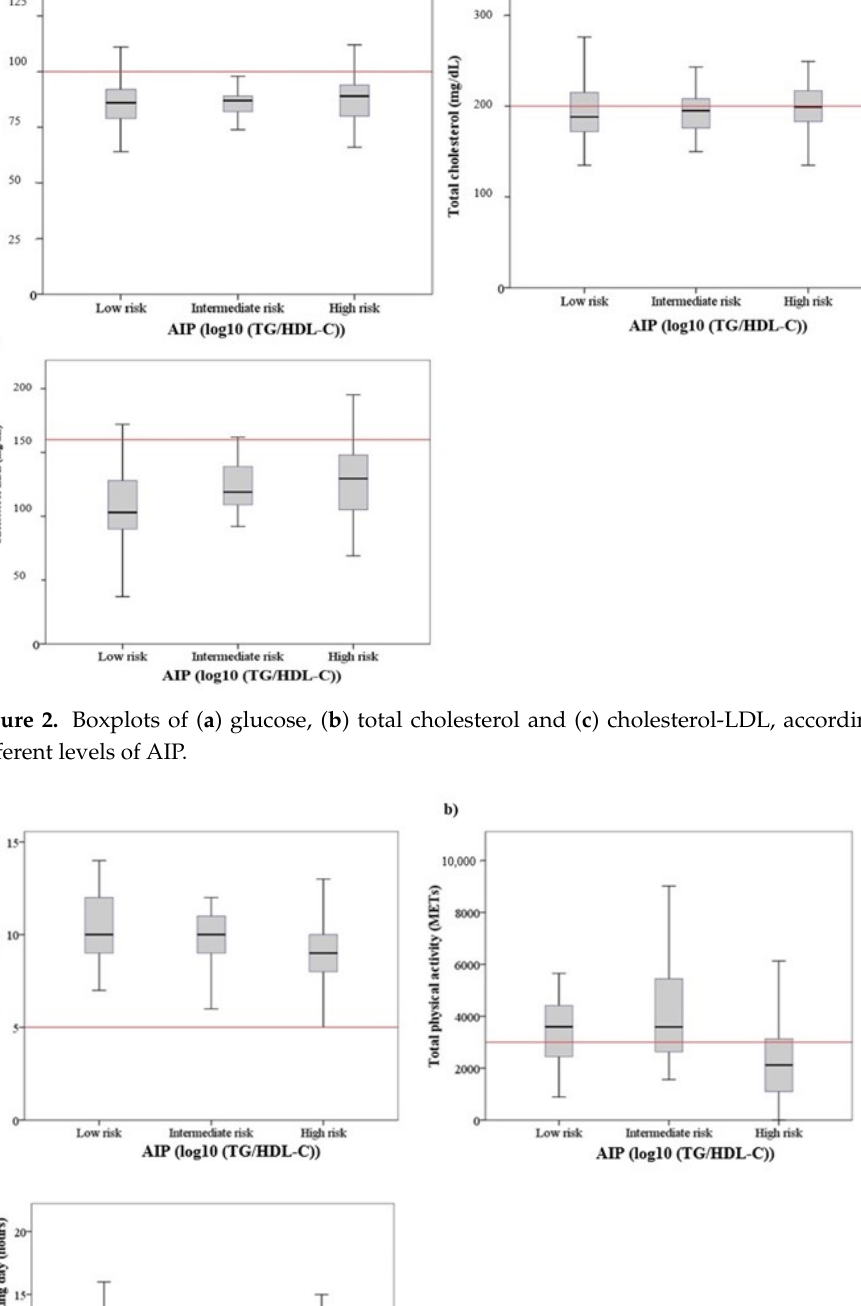
Figure 1. Anthropometric parameters boxplots: ( a ) BMI, ( b ) WHtR and ( c ) %BF, according to the different levels of AIP.